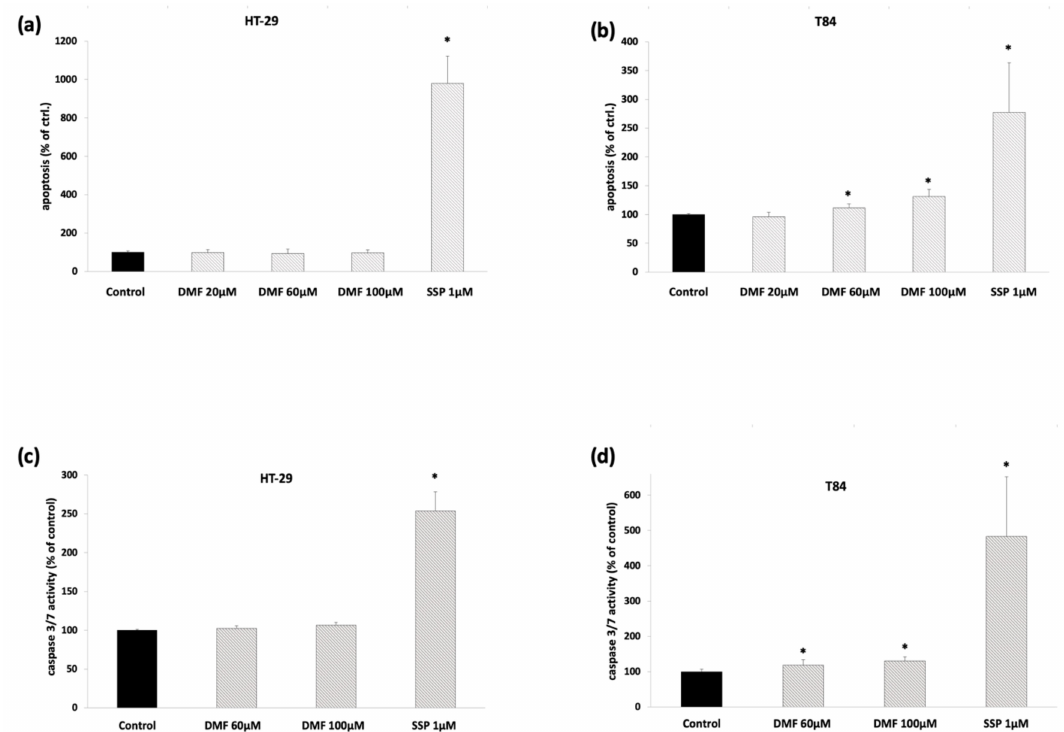
Figure 5. DMF induces apoptosis and caspase-3 / 7 activation in T84 but not HT-29 cells. Analysis of apoptosis using the Cell Death Detection Kit. ( a ) HT-29 cells were treated for 24 h with DMF at the indicated concentrations; ( b ) T84 cells were treated for 24 h with DMF at the indicated concentrations. Analysis of caspase-3 / 7 activity; ( c ) HT-29 cells were treated for 24 h with DMF at the indicated concentrations; and ( d ) T84 cells were treated for 24 h with DMF at the indicated concentrations. Mean values from at least three independent experiments are shown as mean ± SD. * p < 0.05: significant. As a positive control, staurosporine (SSP) 1 µ M was used. DMSO 0.2% served as a solvent